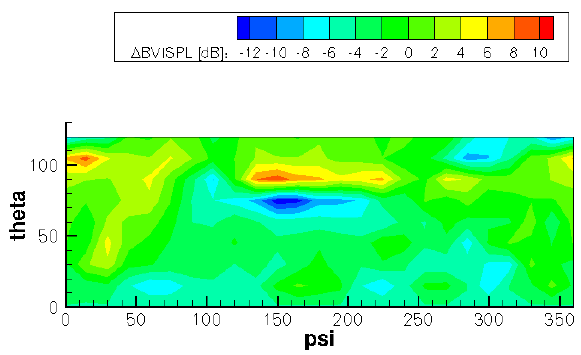
Figure 19: Technique A – B differential BVISPL at point 1 in maneu- ver ID8022.